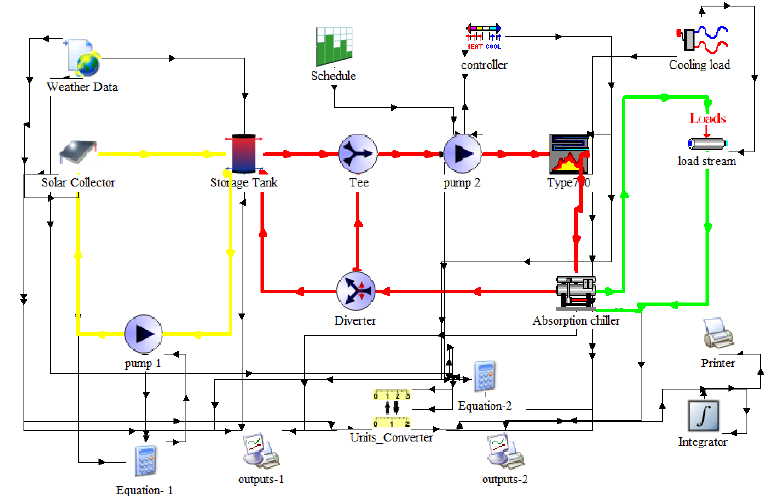
Figure 2. TRNSYS model of solar absorption cooling system (SACS) for modified flow schemes.